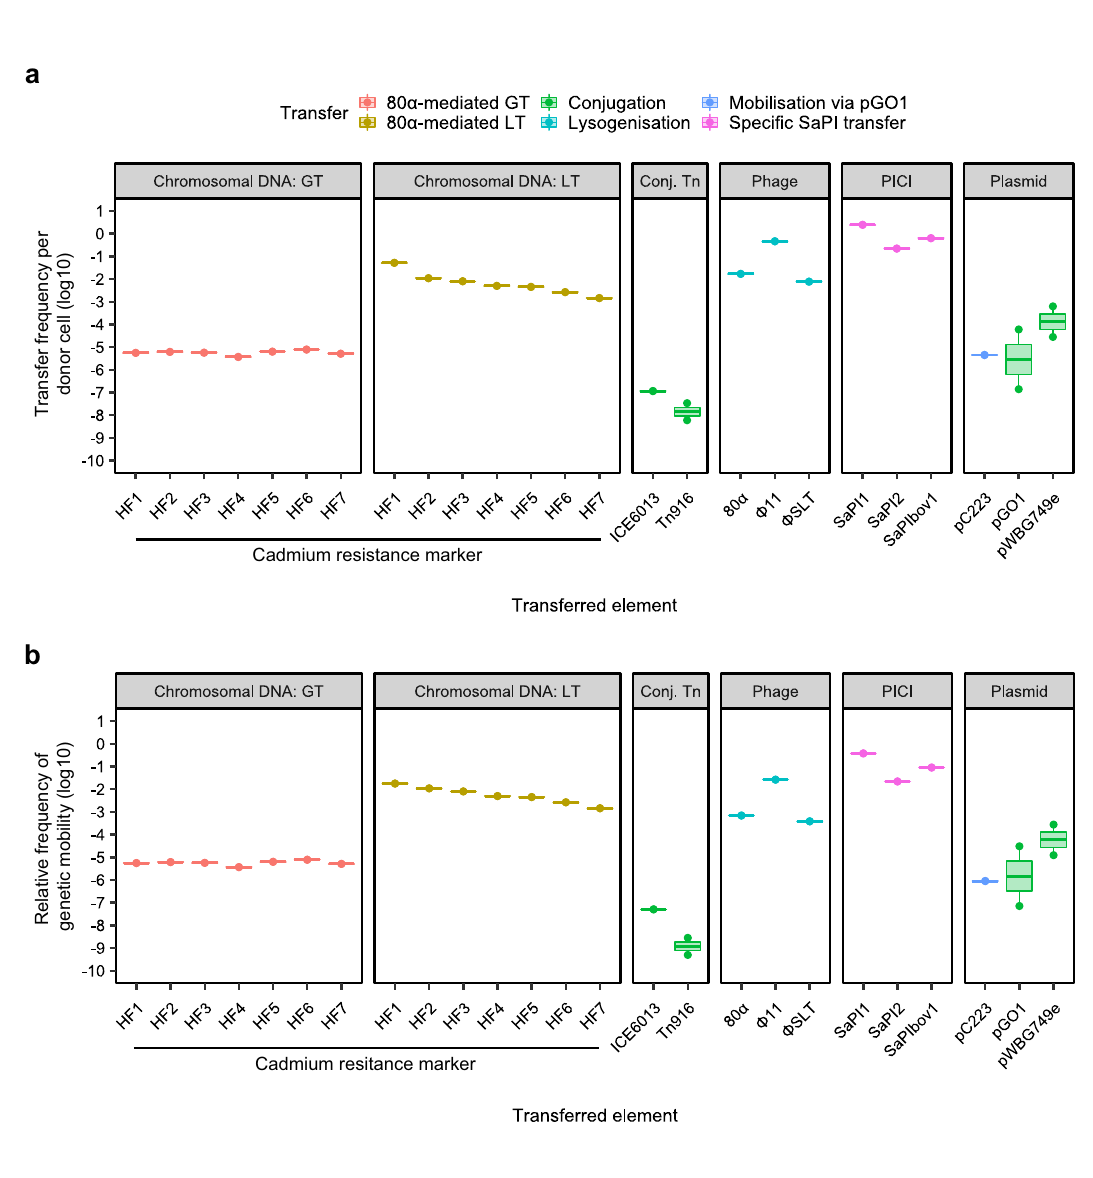
Fig. 2 Genetic mobility via different mechanisms in S. aureus . a Transfer frequencies per donor cell and b relative frequency of genetic mobility (de fi ned as transfer frequency × cargo capacity) of different genetic elements by transfer type. Transfer of chromosomal DNA by phage 80 α via generalised (GT) or lateral (LT) transduction of a cadmium resistance marker located at de fi ned distances from the phage attachment site, conjugative transposons (Conj. Tn), phages, PICIs and plasmids. Data were extracted from literature or acquired through experimentation (see Table 1 for